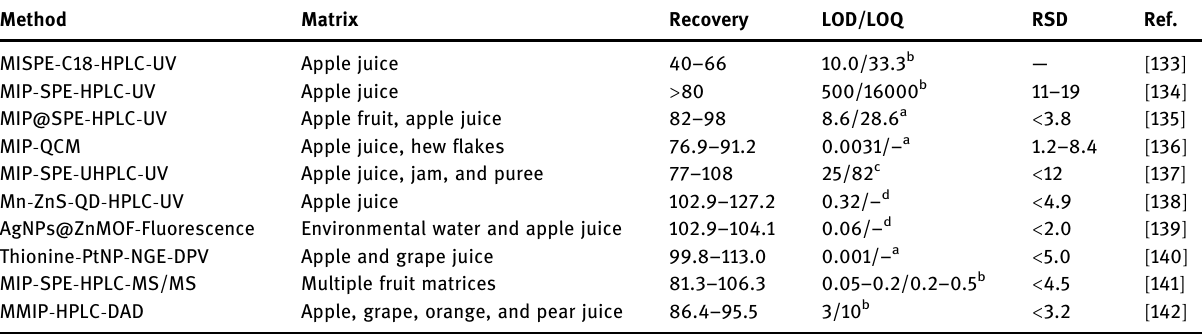
Table 6: Comparison of recovery ( % ) , LODs and LOQs ( a: µg L − 1 ; b: µg kg − 1 ; c: pg injected; d: µmol L − 1 ) and repeatability ( expressed as relative standard deviation, RSD% ) among analytical methods based on MIPs for determining patulin in di ff erent matrices